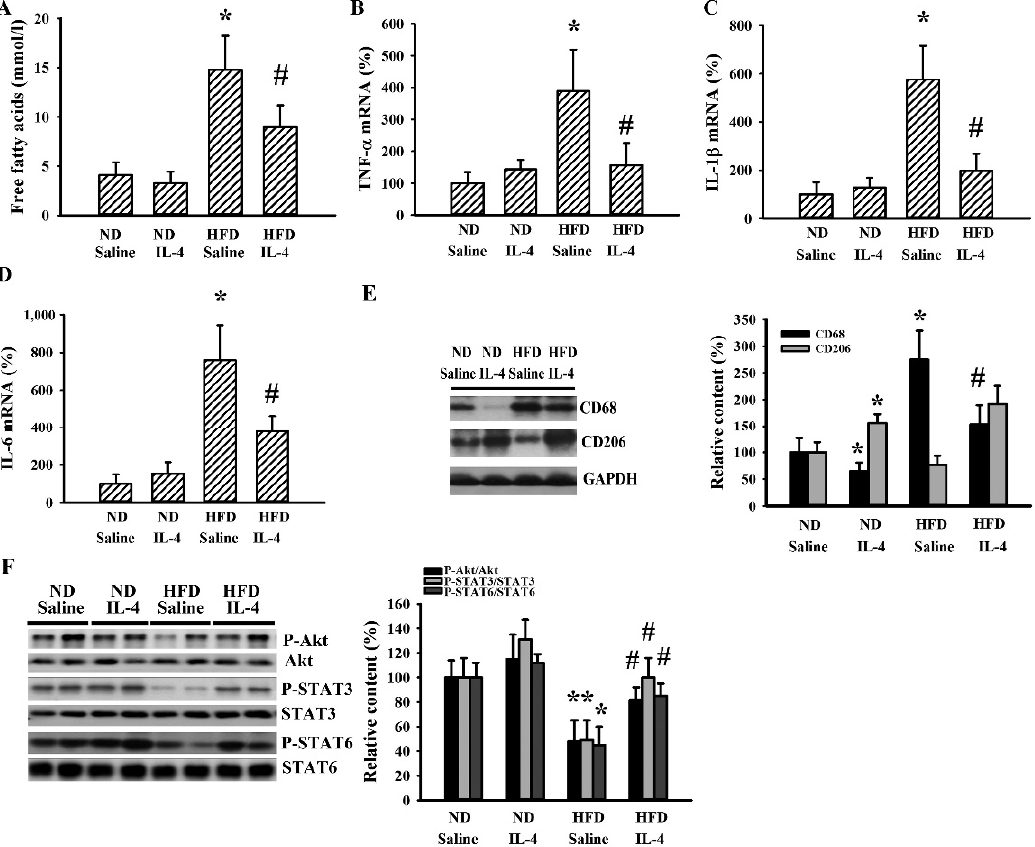
Figure 9. IL-4 ameliorated adipocytic changes in leptin-resistant mice. C57BL / 6 mice were fed the normal diet (ND) or high-fat diet (HFD) for 12 weeks. Simultaneously, normal saline and IL-4 (1 µ g / mouse) were intraperitoneally administrated twice a week for the last 8 weeks. Blood samples were collected and subjected to the measurement of free fatty acids ( A ). Total RNA were extracted from the epididymal fat tissues and mRNA expression measured with qRT-PCR for TNF- α ( B ), IL-1 β ( C ), and IL-6 ( D ). Proteins were extracted from the epididymal fat tissues and subjected to Western blot analysis with indicated antibodies. Representative blots and quantitative data are shown ( E , F ). * p < 0.05 vs. ND/saline group and # p < 0.05 vs. HFD/saline group, n = 6.